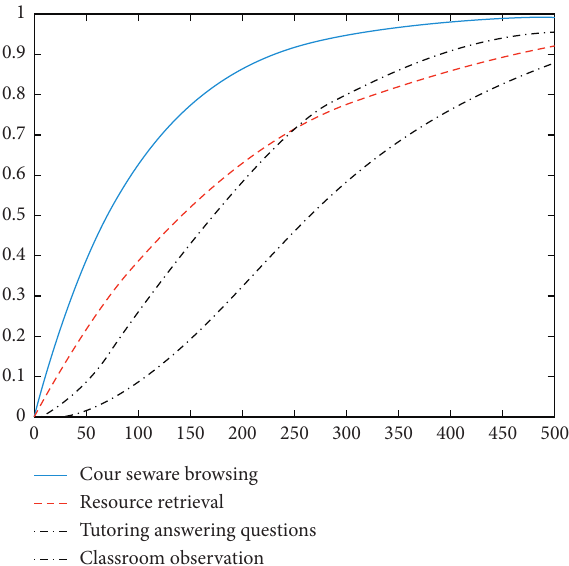
Figure 8: Investigation of application effect.